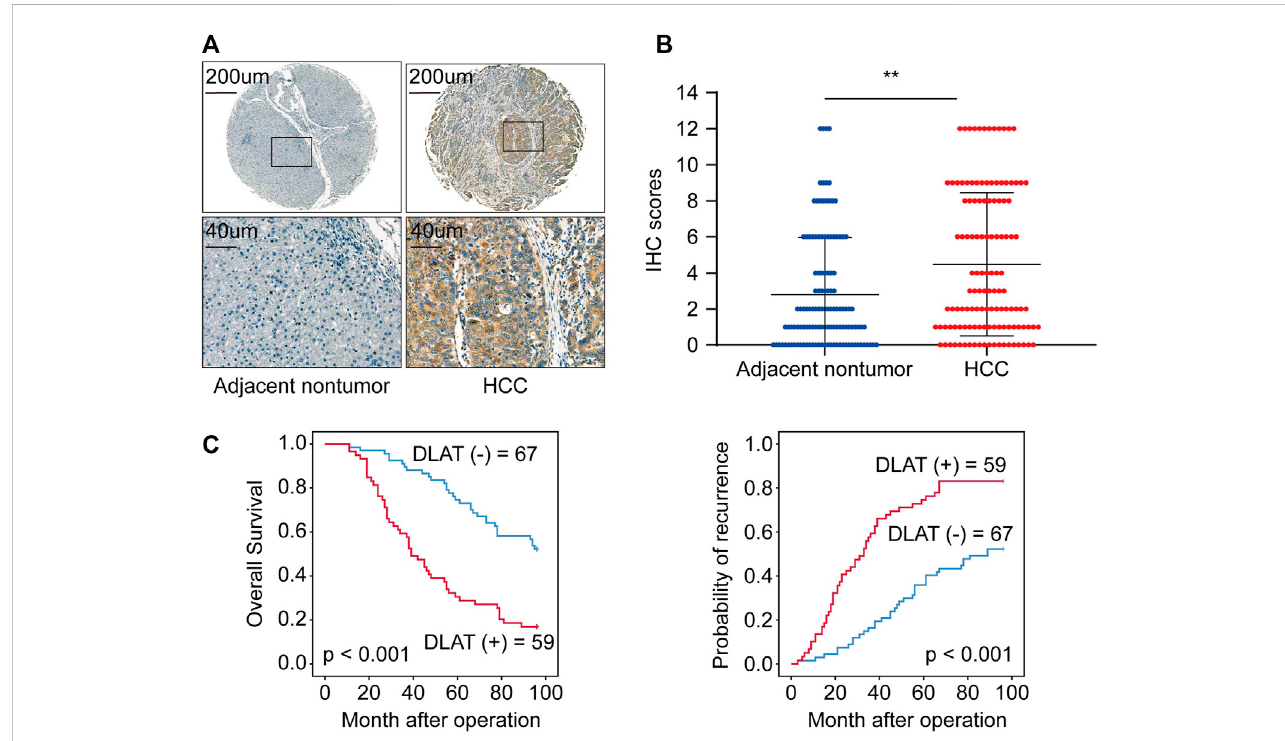
FIGURE 6 DLAT is upregulated in HCC tissues and indicates poor outcome in HCC. (A) The representative IHC staining of DLAT in non-tumor (negative) and HCC (positive). (B) The chart shows IHC scores of DLAT expression in 126 pairs of HCC and normal tissues. (C) Survival analysis suggests high expression level of DLAT indicated poor OS and high recurrence rates in